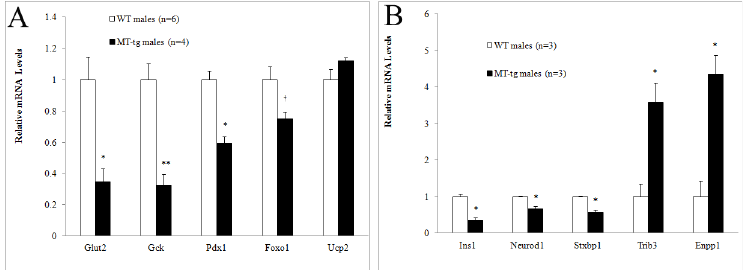
Fig 6. Relative mRNA levels in islets of MT-tg and WT male mice. ( A) using regular RT-PCR, the value of each gene was normalized to Actb and Rpl13a . (B) using PCR Array, the value of each gene was normalized to Gusb , Hprt1 , Hsp90ab1 and Actb . The gene expression level in MT-tg islets was presented as fold relative to WT (set as 1). Data are mean ± SEM. n values represent the number of mice. * p < 0.05, ** p < 0.001, † p = 0.053 vs WT.